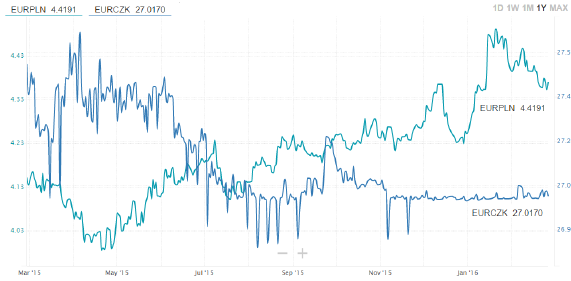
Figure 2: Development of prices EURCZK and EURPLN for the previ- ous time period – year